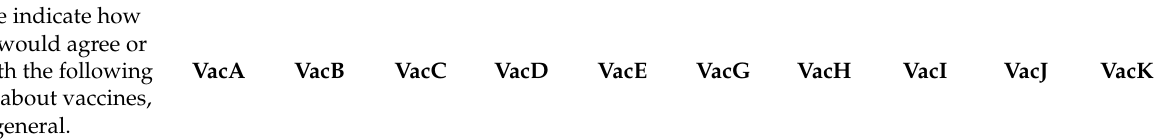
Table 4. Correlations among General Attitudes toward Vaccines (Pairwise deletion of missing